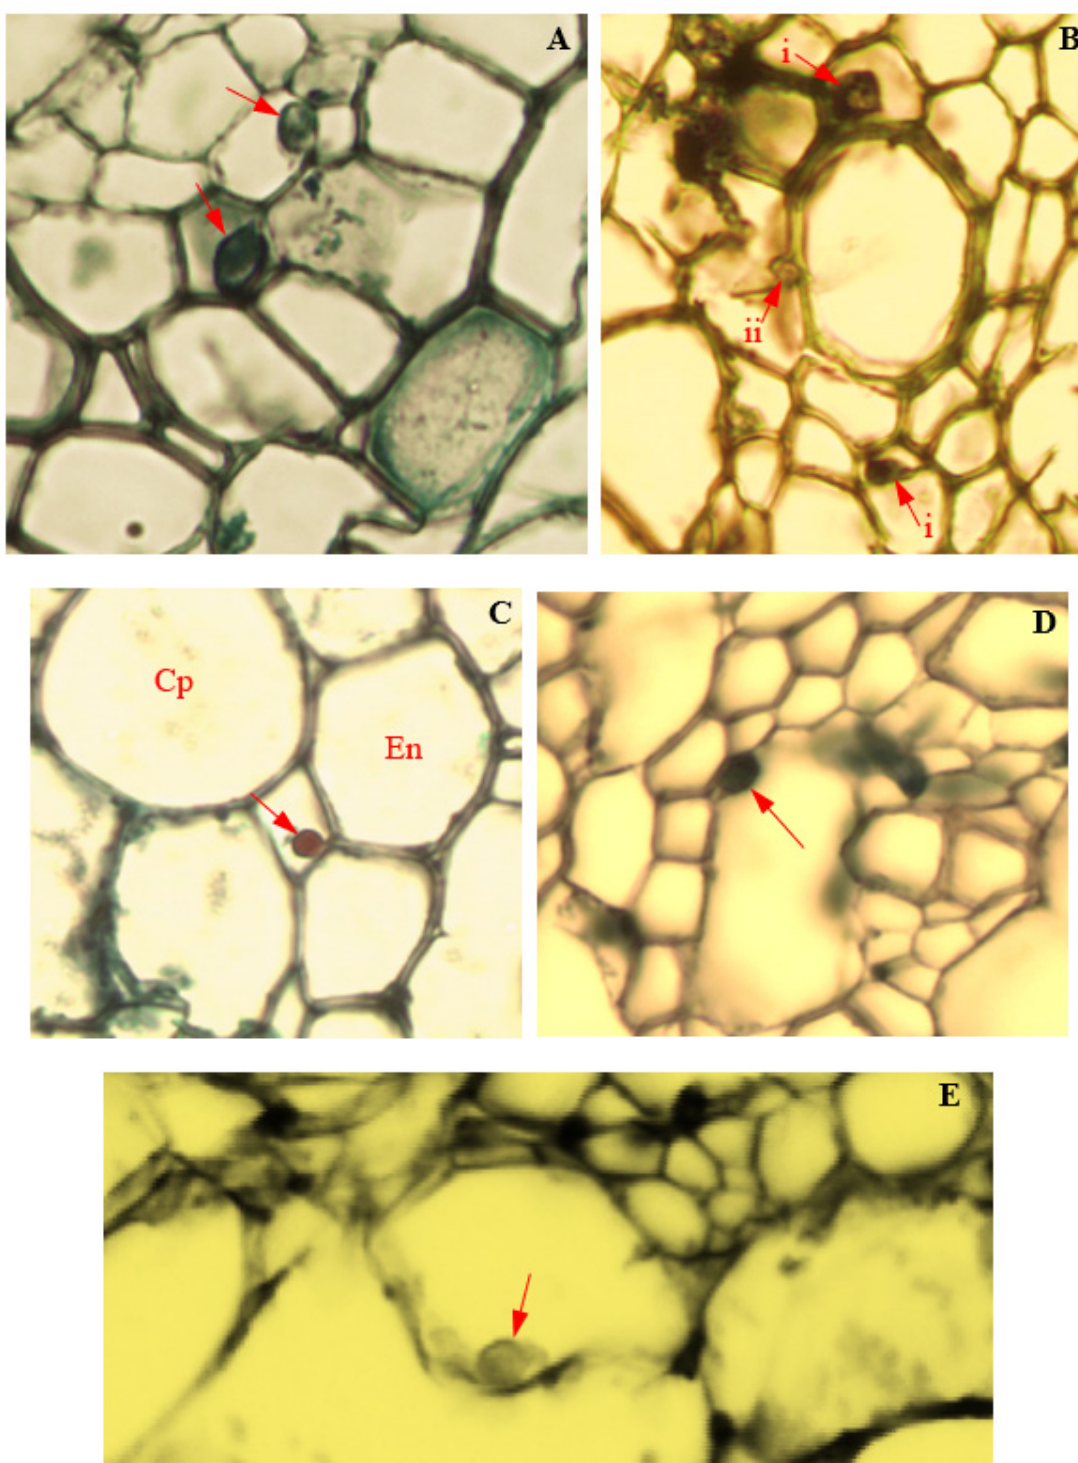
Figure 12. Light micrographs showing the endophytic colonization of corn tissues by Fusarium verticillioides (Magnification 400 × ). Red arrows indicate position of endophyte in the infected ( A ) root pericycle; ( B ) i: root pith; ii: root metaxylem; ( C ) intercellular cellular space between root cortical parenchyma (Cp) and endodermis (En); ( D ) stem protoxylem lacuna; and ( E ) leaf